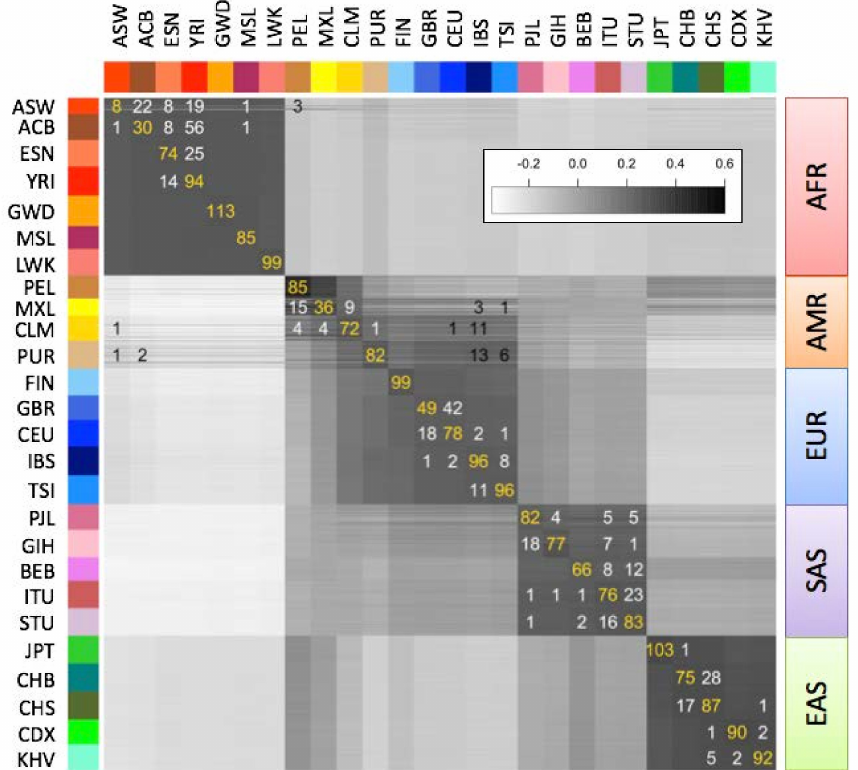
Figure 4. Correlations between the genotype fingerprints of the 2504 individuals (rows) and the average fingerprints of the 26 populations (columns) in the 1000 Genomes Project. Population codes and colors as in Figure 3. Numbers in gold, white, and black denote population assignments: to the same annotated population, to the same continent but different population, or to a different continent, respectively. Inset: correlation color